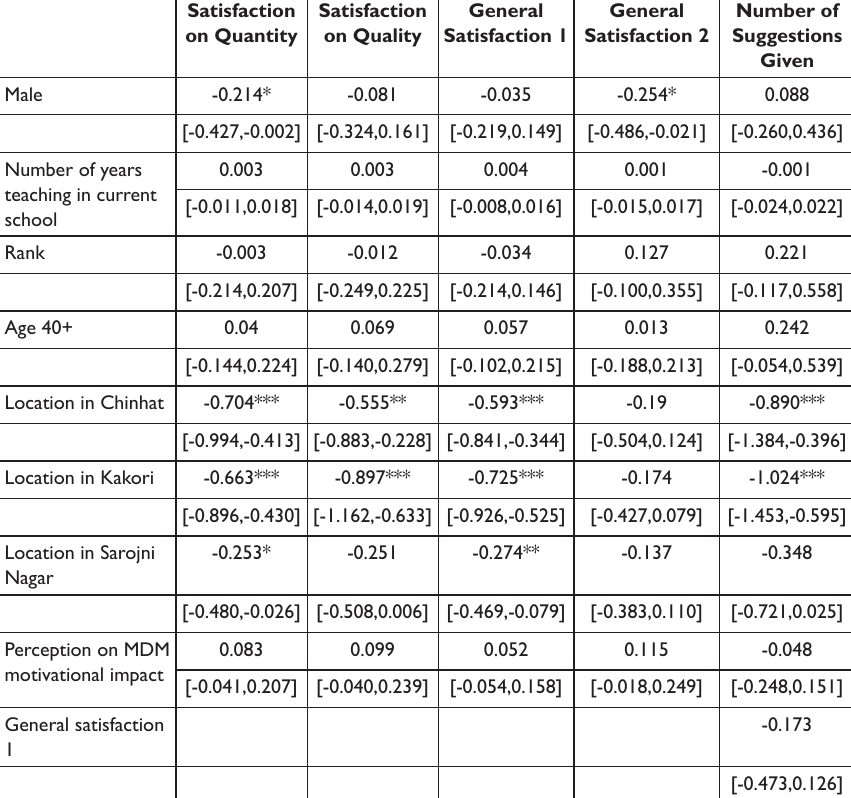
Table 2: regression Analysis of Teachers’ Satisfaction and Number of Suggestions Satisfaction Satisfaction on Quantity on